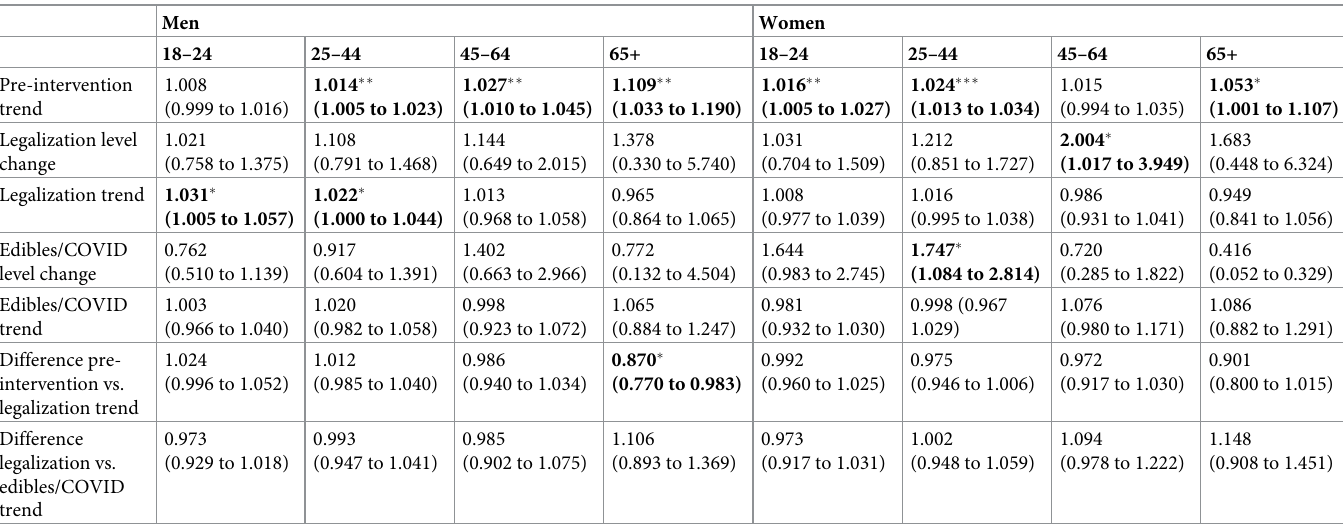
Table 4. Associations between cannabis policies and ED visits in Northern Ontario using negative binomial regression with censored months in the early stages of COVID-19